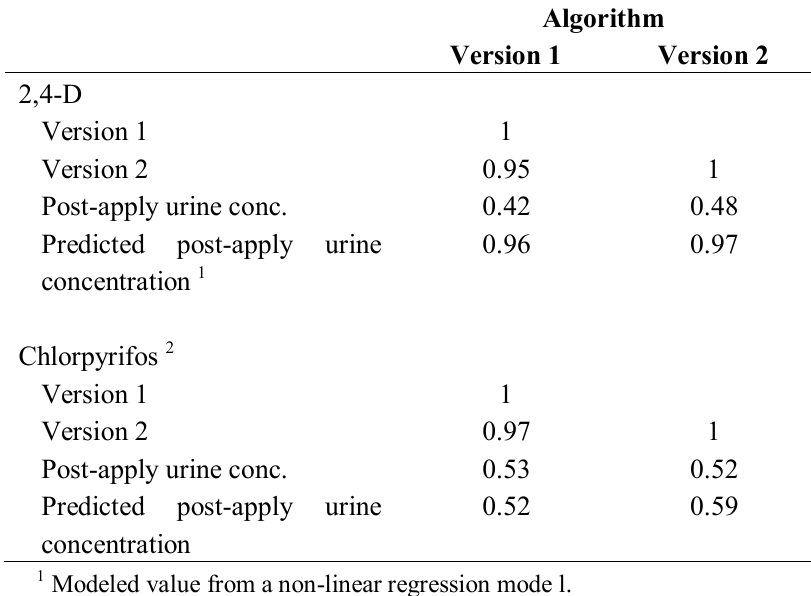
Table 3. Spearman correlation coefficients between Version 1 algorithm scores and measurements of post-application urine 2,4-D and chlorpyrifos and modeled post-application urine concentrations for 2,4-D (N = 88) and chlorpyrifos (N = 17) and Version 2 algorithm scores with post-application urine concentrations and modeled post-application urine concentrations for 2,4-D and